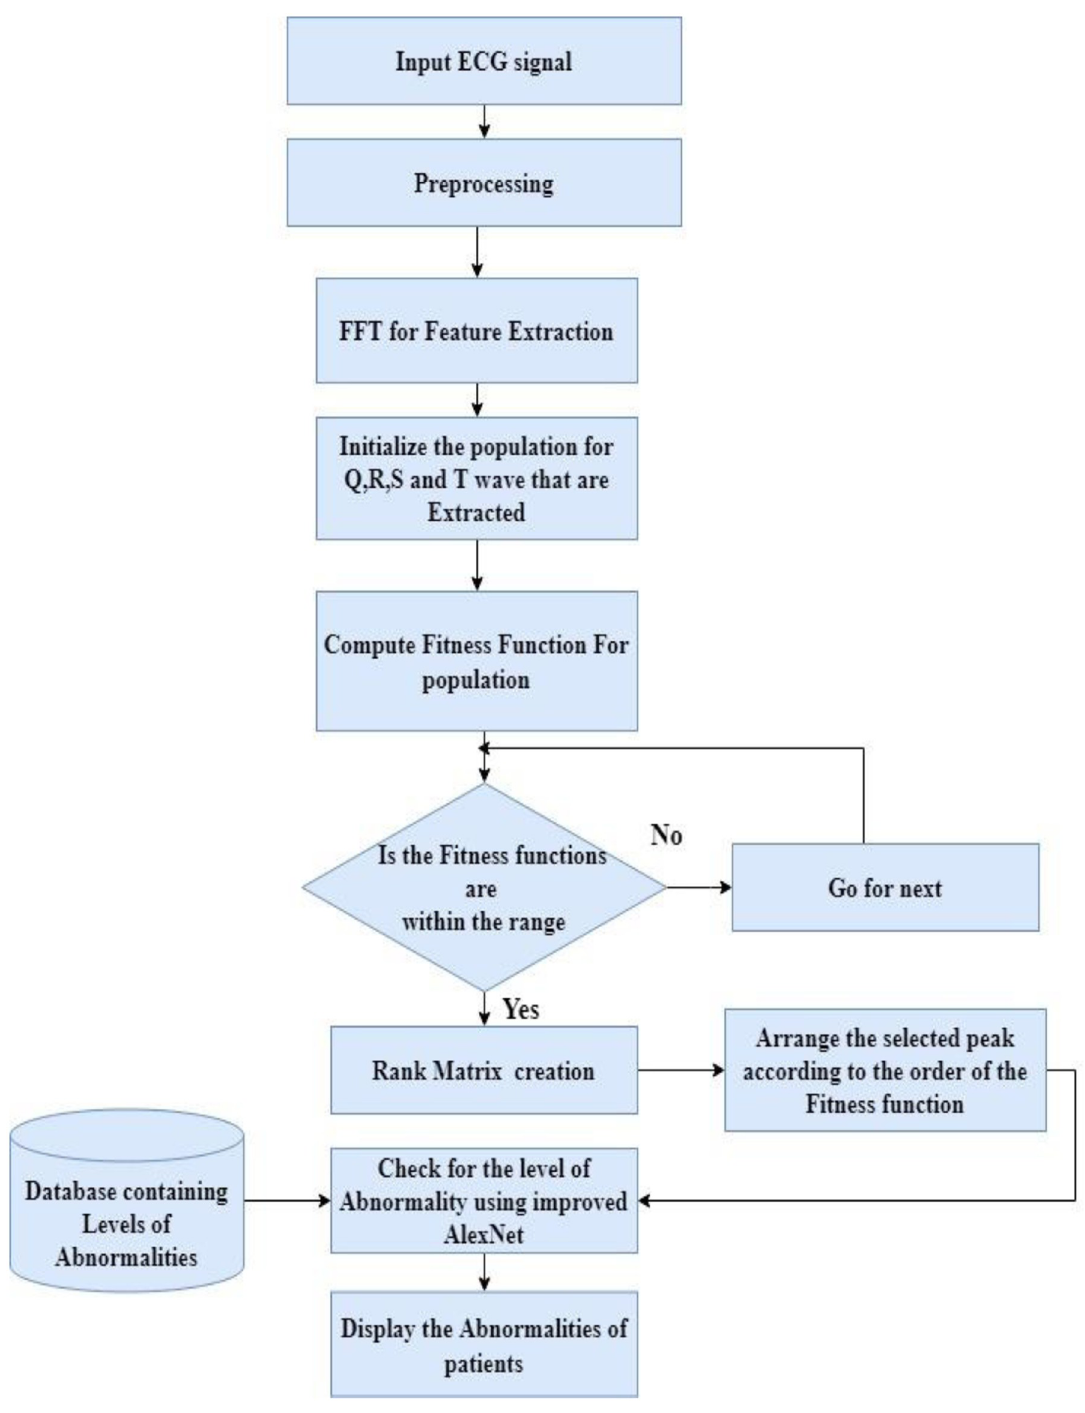
Fig 8. Recording of ECG signal with and without noise.